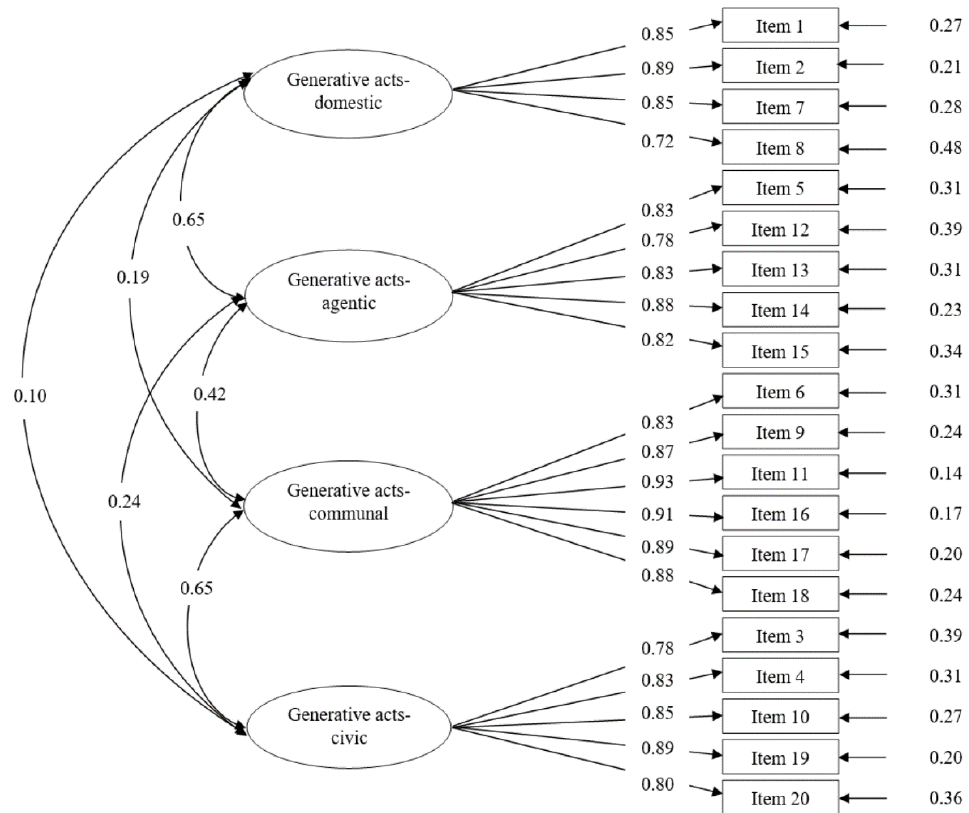
Figure 1. Validation of the factor structure with CFA (Subsample B, random half; n = 507). All coefficients in Figure 1 were standardized factor loadings statistically significant at p < 0.001 level.